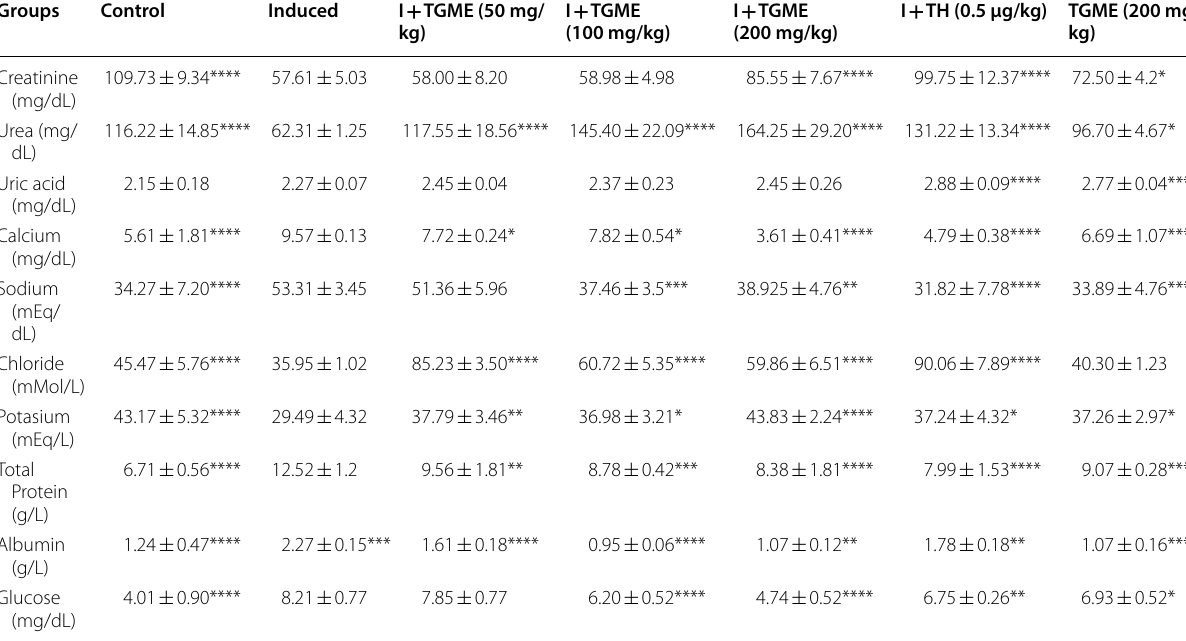
Table 5 Effect of aqueous methanolic leaf extract of Triclisia gilletii on urine biochemistry parameters in animals administered ethane-1,2-diol Groups